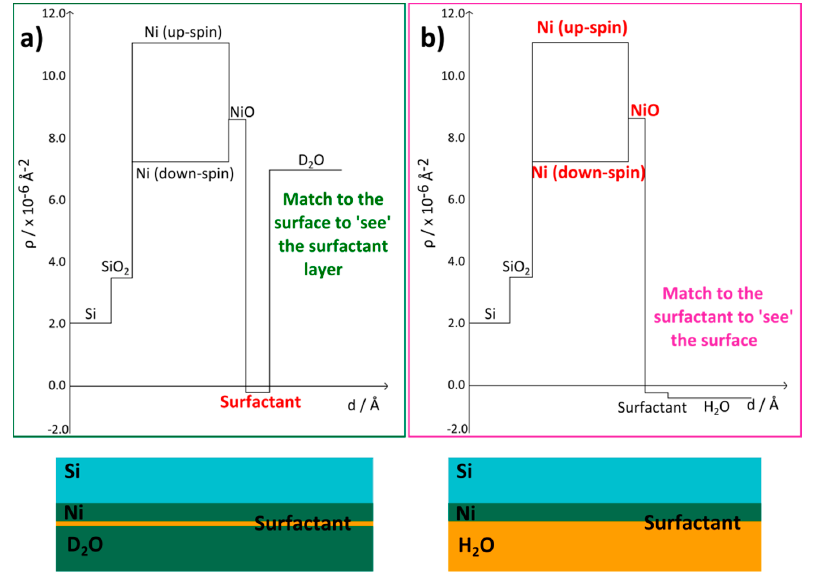
Figure 8. Simulated SLD profiles for the nickel/surfactant/acid system in ( a ) D 2 O and ( b ) H 2 O, showing how use of the different contrasts allows emphasis on different components of the system. Reproduced with permission from [75], ACS Publications, 2015.